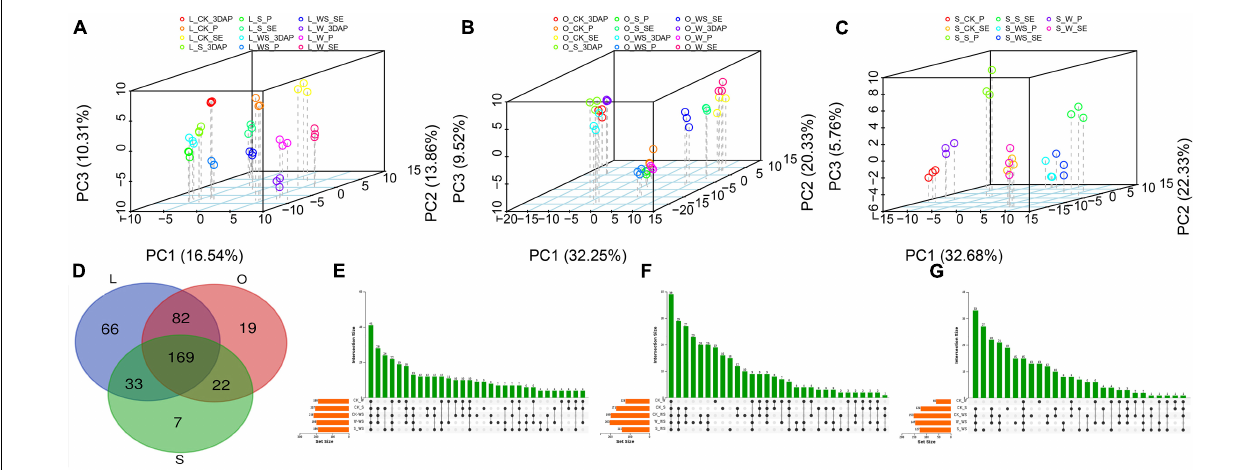
FIGURE 5 | Principal component analyses (PCA) and Venn diagrams showing results of metabolomics analyses. PCA of metabolites in leaves (A) , ovaries (B) , and silks (C) . Venn diagrams showing overlapping of differentially accumulated metabolites in different tissues (D) and overlapping of differentially accumulated metabolites in leaves (E) , ovaries (F) , and silks (G) in control (CK) and waterlogging + shading (WS), waterlogging (W), and shading (S) treatment groups. L (leaf), O (ovary), S